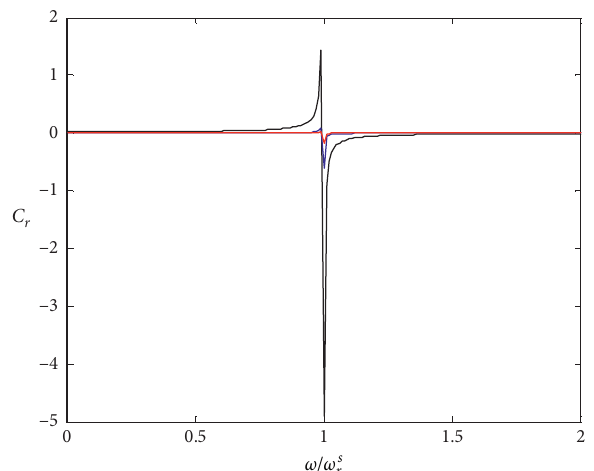
amplitude C r with pipe frequency ratio.